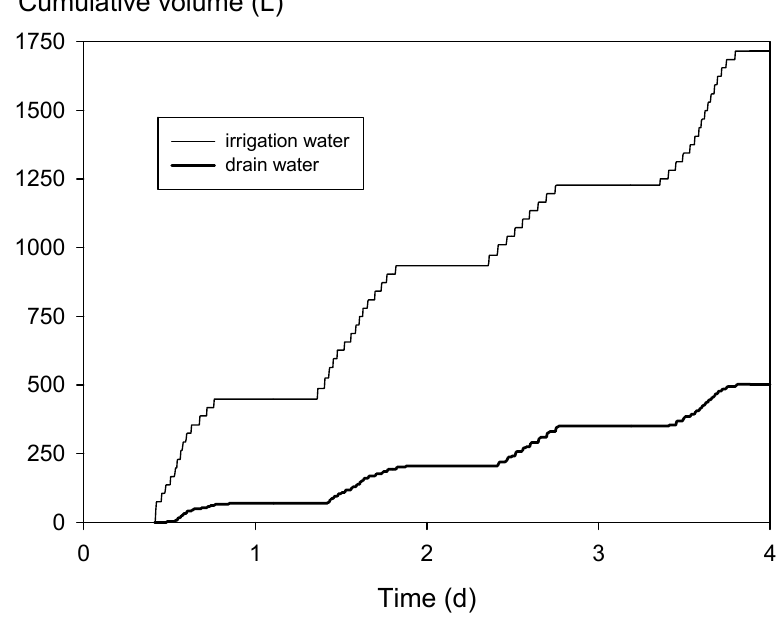
Figure 4. Cumulative irrigation and drain water volumes as a function of time as measured in the experiment. Irrigation is the flow from the mixing reservoir to the cultivation reservoir, and drainage is the flow from the cultivation reservoir to the filter reservoir. Time zero is 00.00 h 31 May.